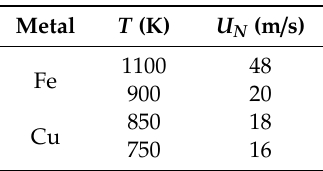
Table 1. Typical growth rates ( U N ) values at some temperatures for the studied metals estimated from an average single crystal radius measured in two mutually perpendicular directions.